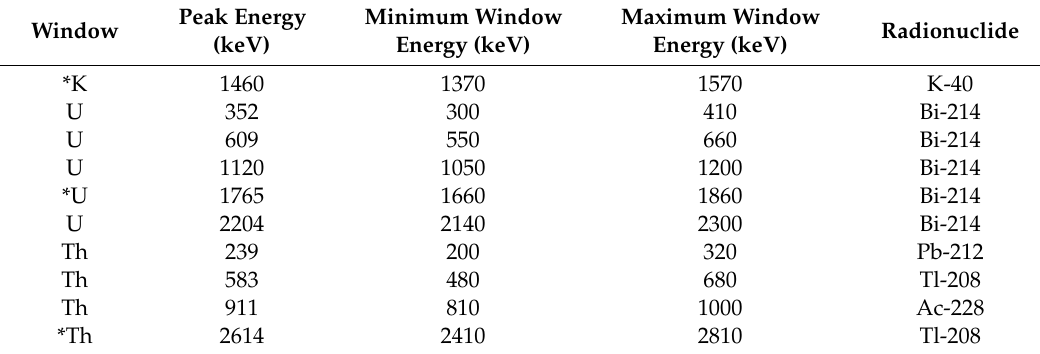
Table 1. Gamma-ray energies and associated spectral windows utilised for natural radionuclide mapping, modified from [23]. The primary windows typically used for spectroscopic identification of K, U and Th are all indicated